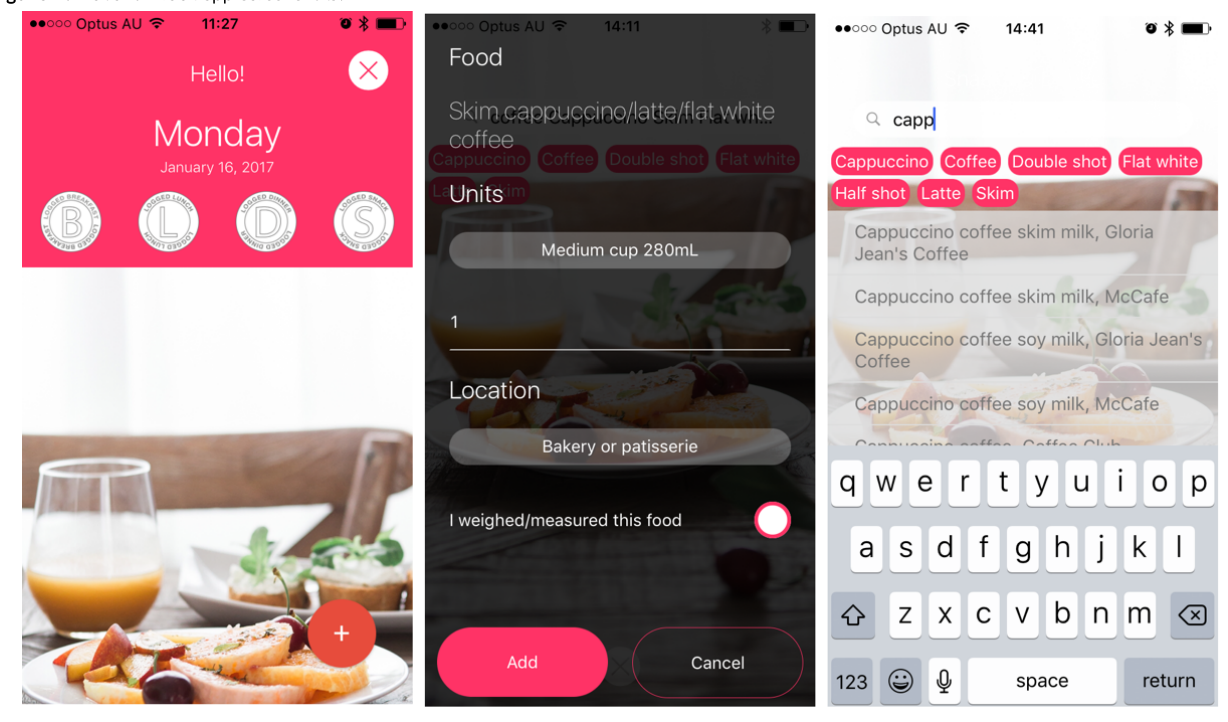
Figure 1. Eat and Track app screenshots.